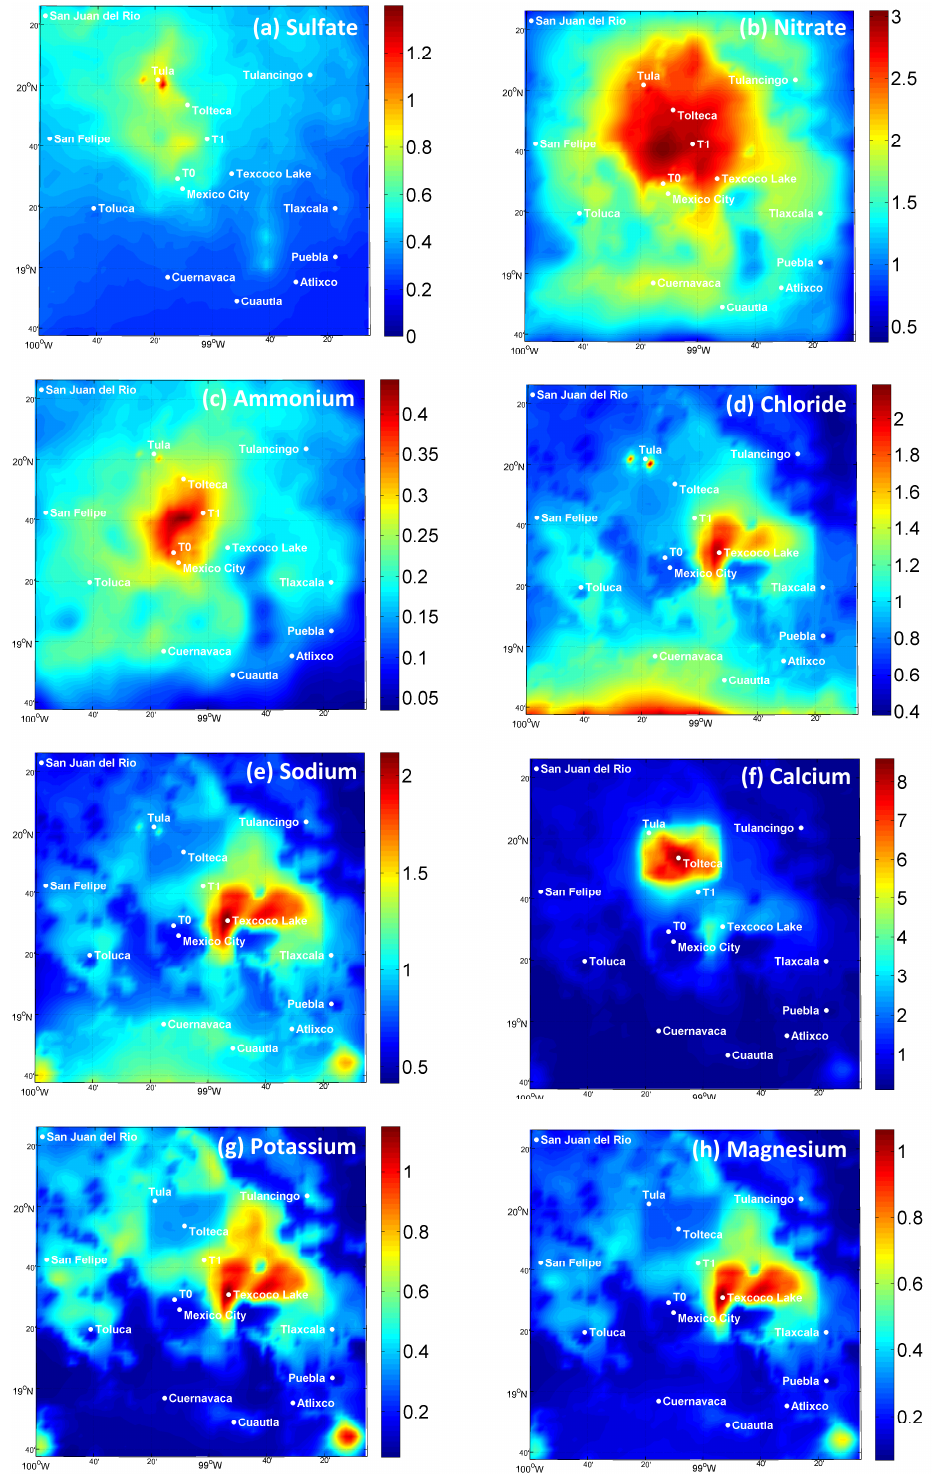
(a) sulfate, (b) nitrate, (c) 1-10